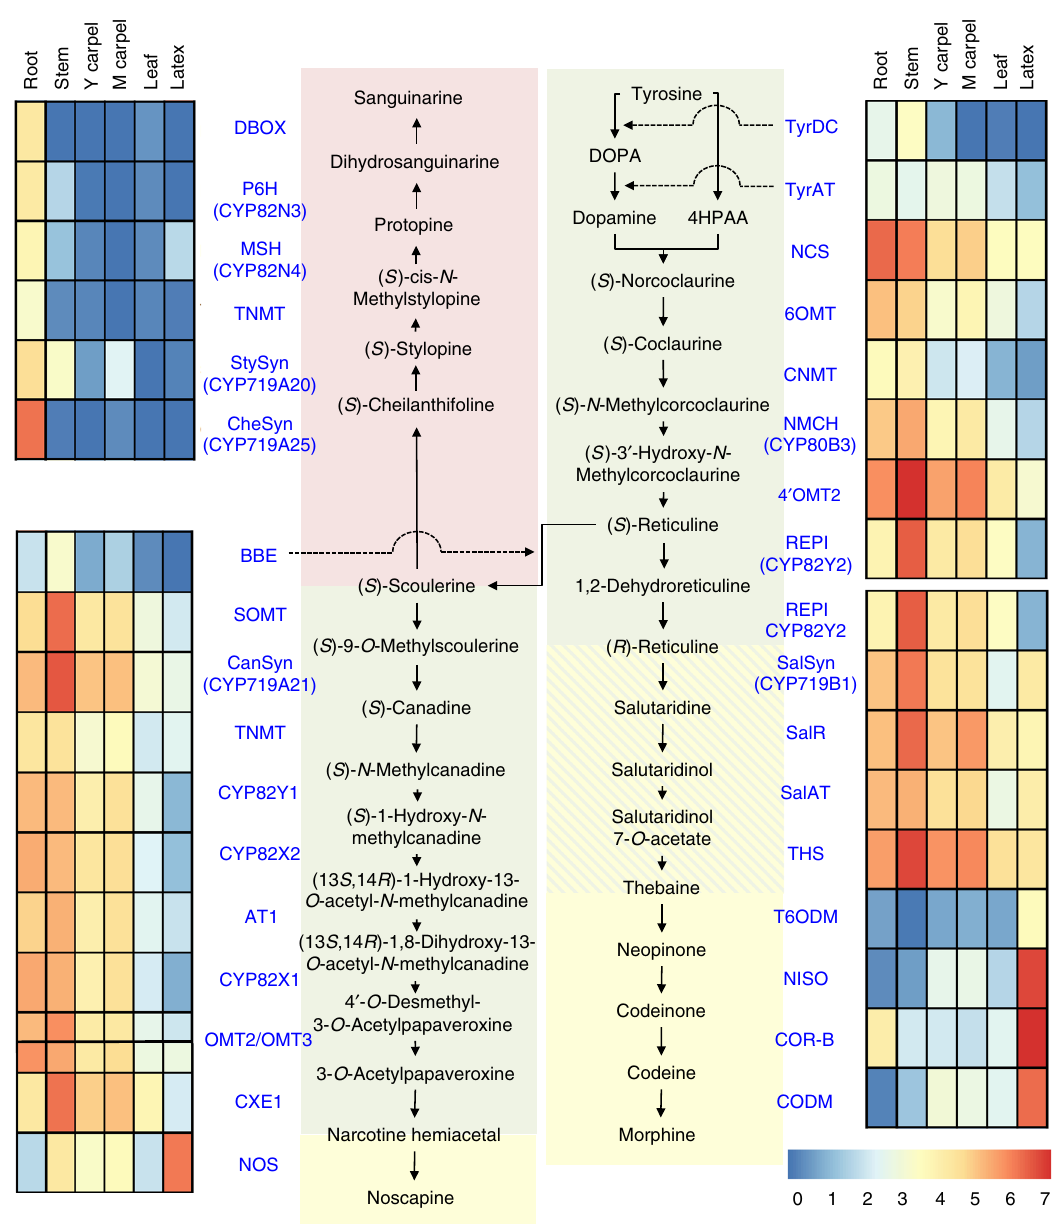
Fig. 1 Genes involved in BIA biosynthesis in six tissues of the opium poppy. Cellular localization of gene-expression activity (log 10 scale) in sieve elements (olive-green), laticifers (yellow), both sieve elements and laticifers (yellow with diagonal olive-green lines), and roots (red) is shown. Gene names are in blue text (aliases are in brackets) and their alkaloid products are in black text ( fi nal products are in bold). YC young capsule, MC mature capsule. Source data are provided as a Source Data fi